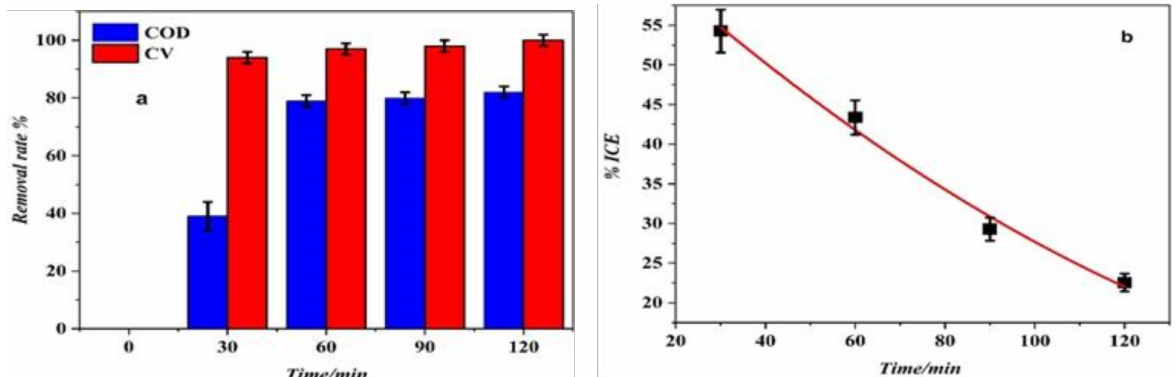
Figure 9. Temporal variation of COD and CV removal rate during electrolysis on Ti/Pt/SnO 2 anode. ( a ) Instantaneous current efficiency ( b ). Operating conditions: [CV] 0 = 10 mg L − 1 , 50 mA cm − 2 , initial pH = 7, temperature = 25 ◦